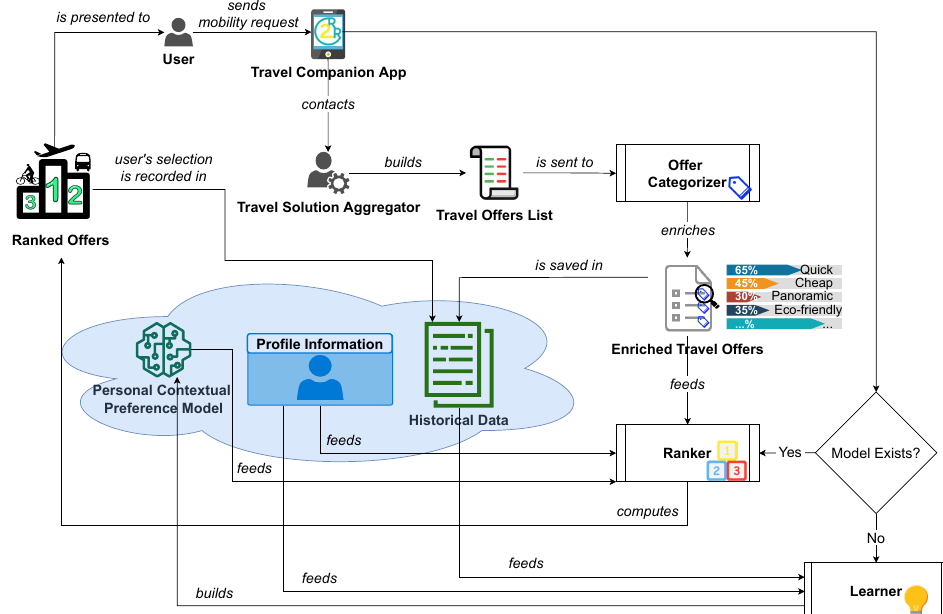
Figure 1. High-level representation of